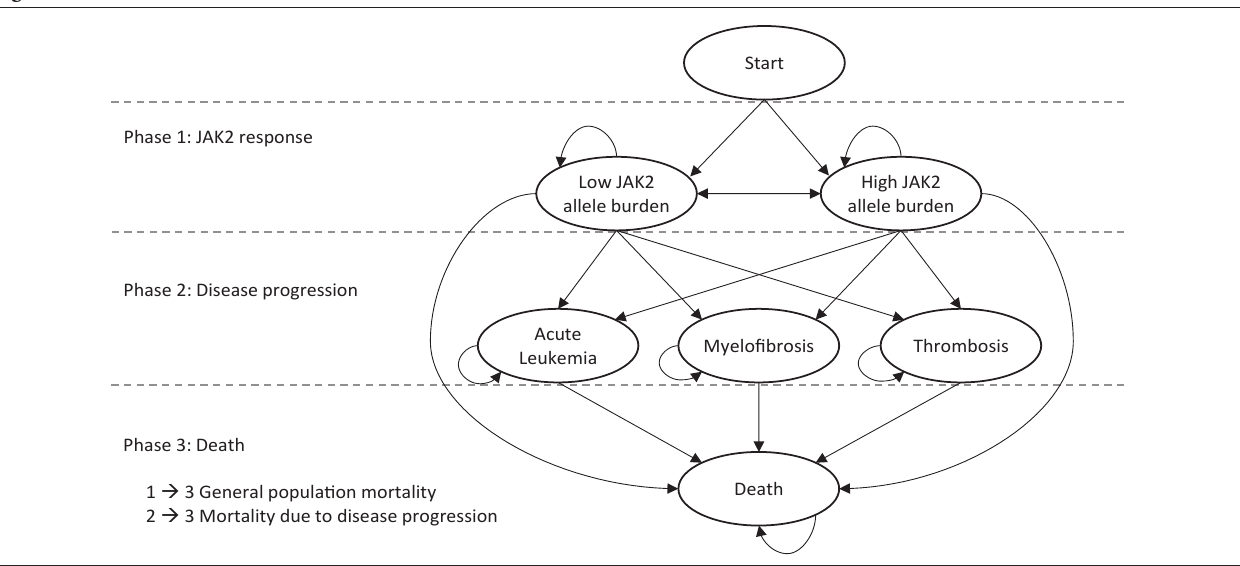
Figure 1. Model Overview